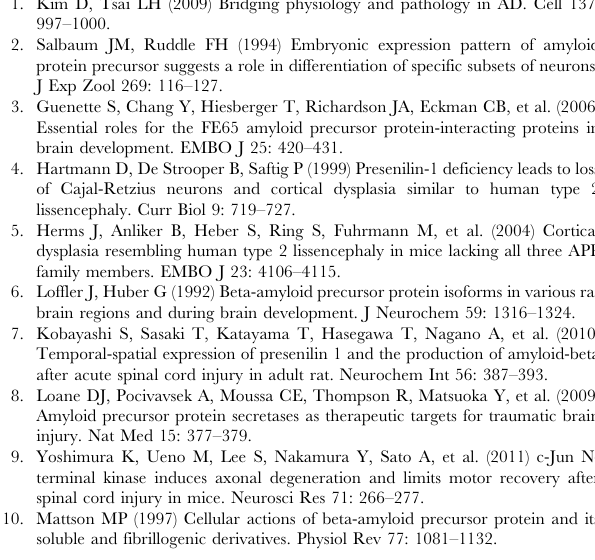
Figure S1 Distribution histograms of the neurite length. (A) Cells were treated with human IgG-Fc or various doses of sAPP a for 24 h. sAPP a increased the ratio of the longer neurites. n =3. (B) Cortical neurons were cocultured with mock or sAPP a - transfected CHO cells for 24 h. Neurons cocultured with sAPP a - transfected CHO cells increased the ratio of the longer neurites. n =7. (C) Cortical neurons were transfected with scramble siRNA (control) or p75 siRNA. Three days after transfection, the neurons were incubated with sAPP a for 24 h. Knockdown of p75 NTR reversed the effect of sAPP a on longer axons to control levels. n =3. (D) Cortical neurons were treated with sAPP a for 24 h and/ or PKA inhibitor, KT5720. Treatment with KT5720 suppressed the effect of sAPP a on neurite outgrowth. n= 3. The mean lengths of the longest neurite per neuron were measured by image J software and represented in the graph. The graph showed the mean 6 SEM of independent experiments. The number of neurons was 150 for each experiment. ** p , 0.01, Kolmogorov- Smirnov